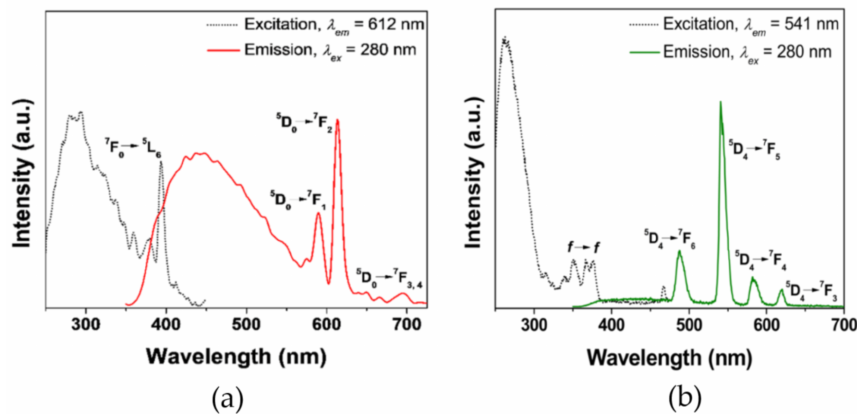
Figure 3. Excitation (dashed traces) and emission (solid traces) of 1.0 × 10 − 5 M ( a ) Eu III and ( b ) Tb III complexes of BimOEt 3 in ethanol at 298 K.